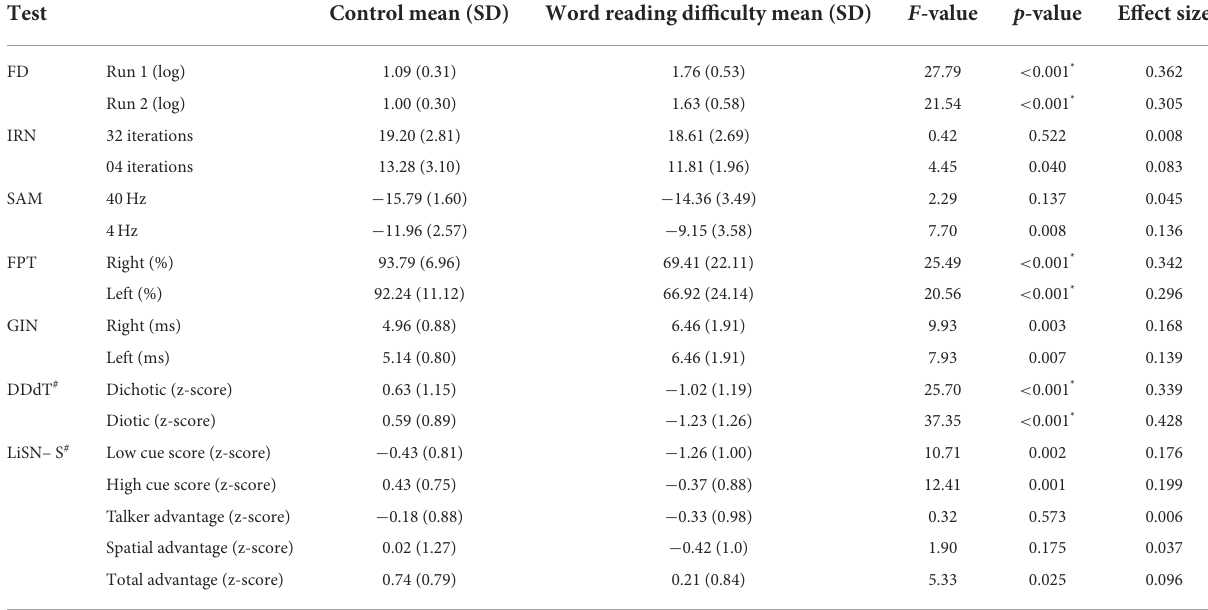
TABLE 3 Univariate ANOVA results alongside the means (and standard deviations in parentheses) across the two groups for the individual auditory processing tests. Test Control mean (SD) Word reading difficulty mean (SD)